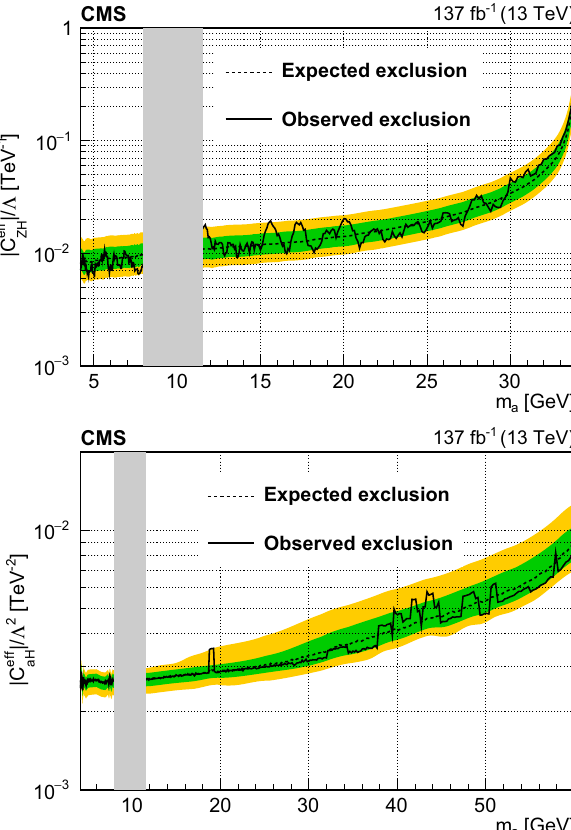
Fig. 7 95% CL limit on C ZH /Λ and C aH /Λ 2 as function of m a . Black curves are the expected upper limits, with one and two standard- deviationbandsshowningreenandyellow,respectively.Thesolidblack curves represent the observed upper limits. The grey band corresponds to the excluded region around the bb bound states of